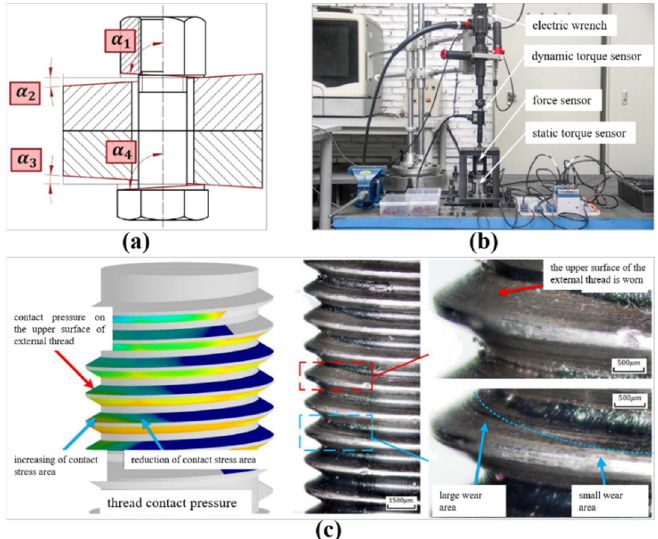
Figure 5. Schematic diagram of the bolt contact stress distribution after introducing manufacturing errors [37,38]: ( a ) Cumulative nut support surface non-parallelism deviation. ( b ) Tightening test system. ( c ) CCD image of thread surface wear after tightening.